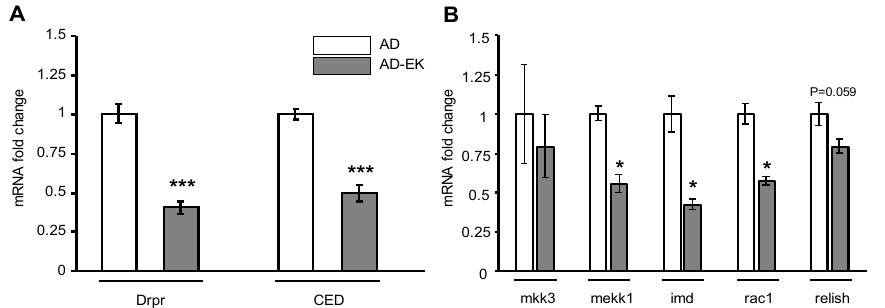
Figure 3. Ergosta-7,9(11),22-trien-3 β -ol decreased the expression of ( A ) microglial activation and ( B ) inflammatory markers. Error bar stands for standard error of mean, while * and *** denotes p < 0.05 and 0.001 in Student’s t -test, respectively. AD denotes Alzheimer’s model. AD-EK denotes Alz- heimer’s model treated with ergosta-7,9(11),22-trien-3 β -ol (EK100).